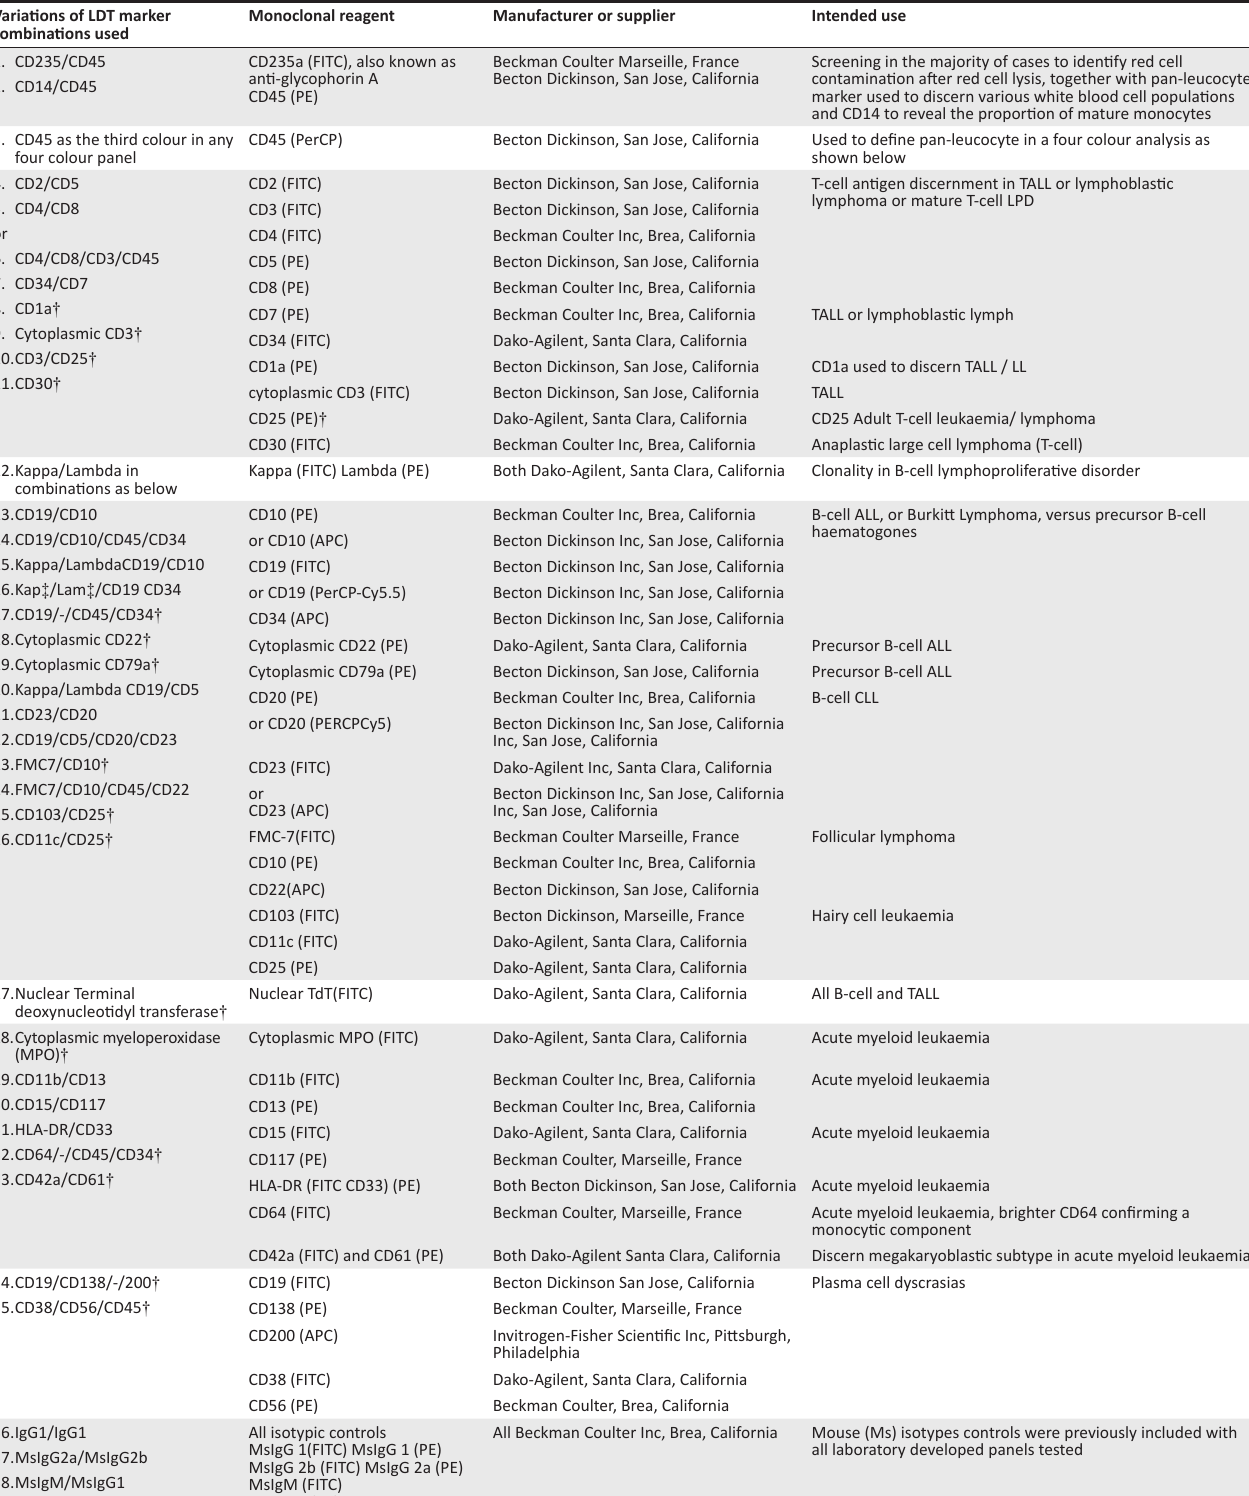
TABLE 1: Summary of the laboratory developed test panels and monoclonal antibody combinations and respective fluorochromes used during routine diagnostic workup at the Charlotte Maxeke Johannesburg Academic Laboratory in Johannesburg, South Africa, August 2019 – November 2019. Variations of LDT marker combinations